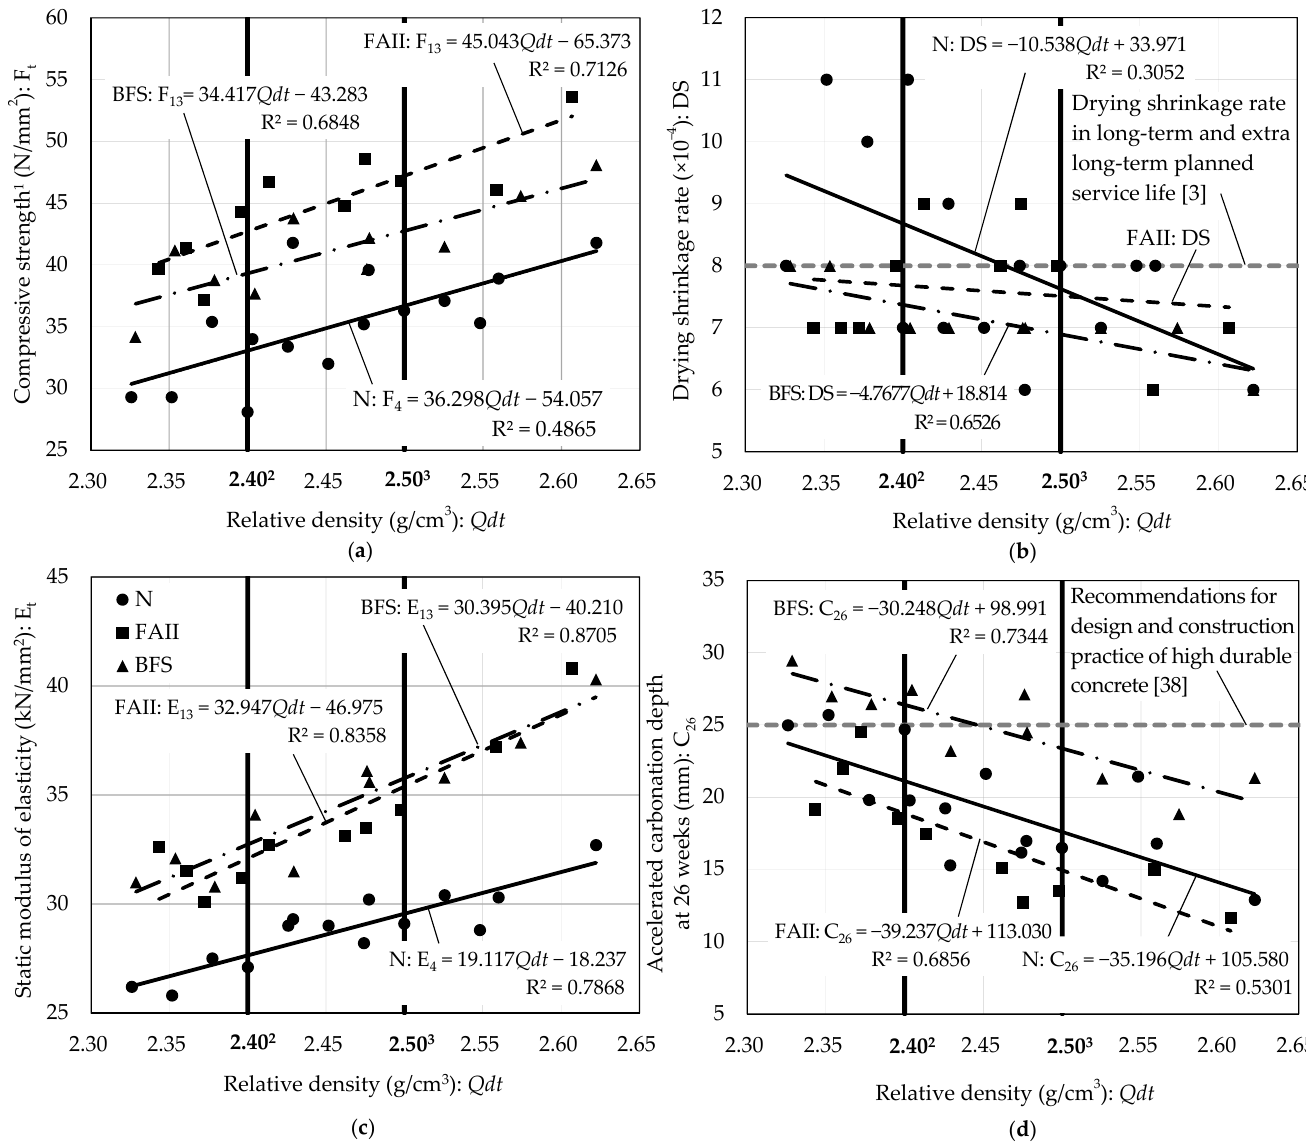
Figure 9. Correlation between relative density and ( a ) compressive strength, ( b ) drying shrinkage rate, ( c ) static modulus of elasticity, and ( d ) accelerated carbonation depth at 26 weeks. 1 Experimental results of N specimens at 4 weeks and those of FAII and BFS specimens at 13 weeks are shown. 2 Relative density was calculated using the lower limit of density in the oven-dry condition (Appendix A) and upper limit of the replacement ratio for recycled coarse aggregate class L and recycled fine aggregate class L according to RAC class M2. 3 Relative density was calculated using the lower limit of density in oven-dry condition (Appendix A) and upper limit of the replacement ratio for recycled coarse aggregate class L according to RAC class